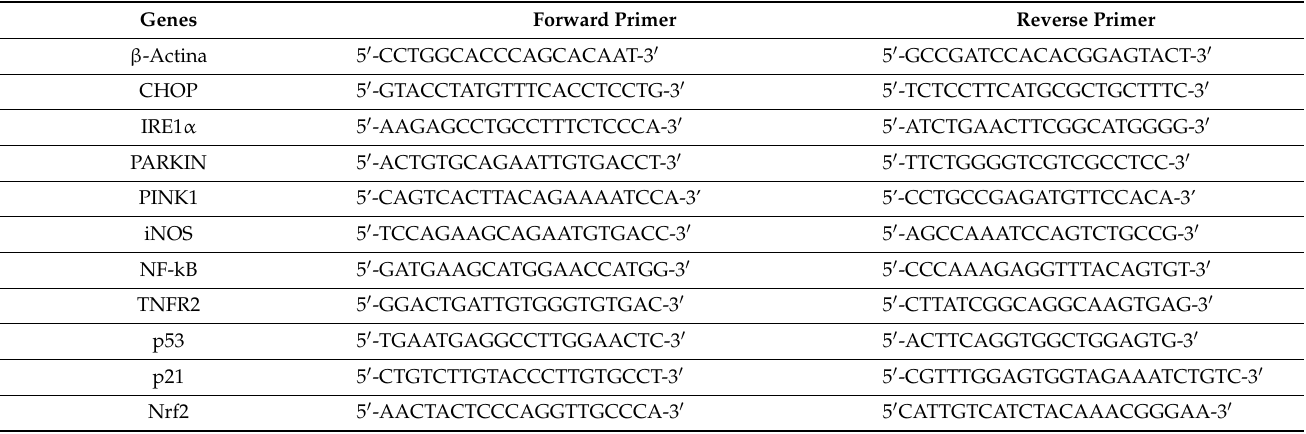
Table 1. List of primers used in this